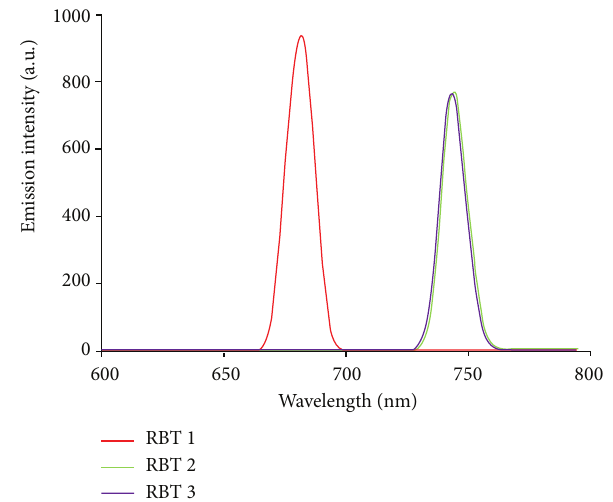
Figure 2: Emission spectra of the RBT1 (red), RBT2 (green), and RBT3 (purple) complexes at a concentration of 0.001 g/dm −3 in (CH 3 Cl/MeOH, 1: 1,